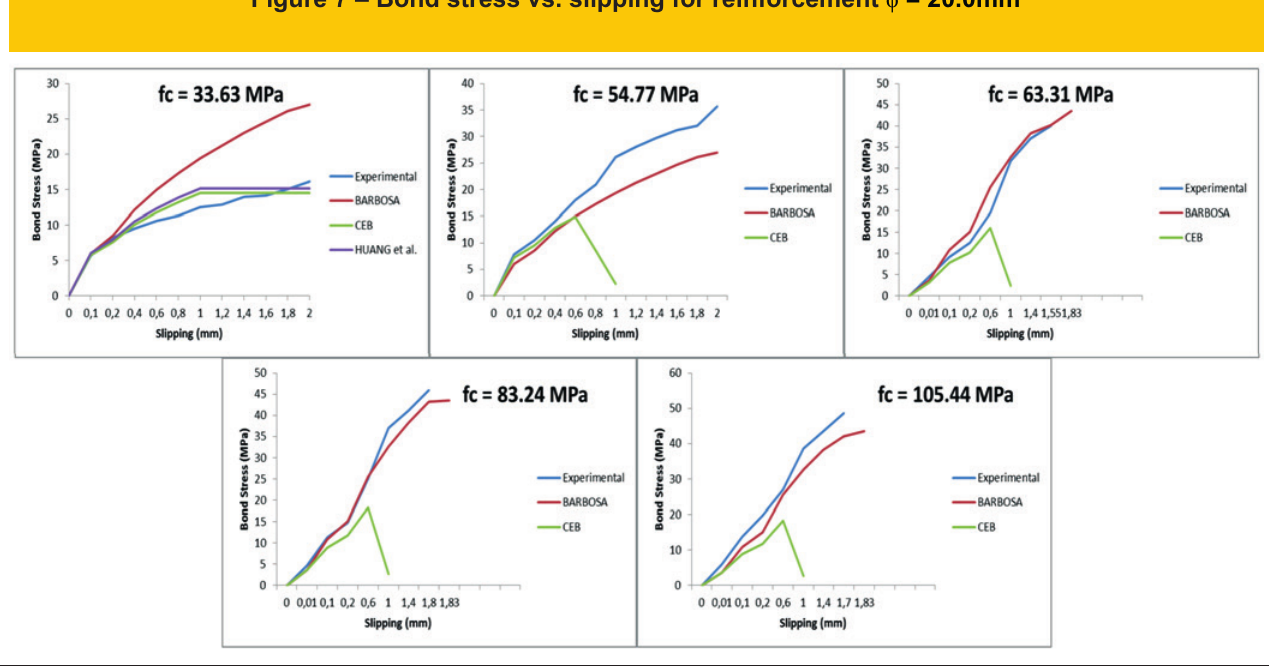
Figure 7 – Bond stress vs. slipping for reinforcement f =